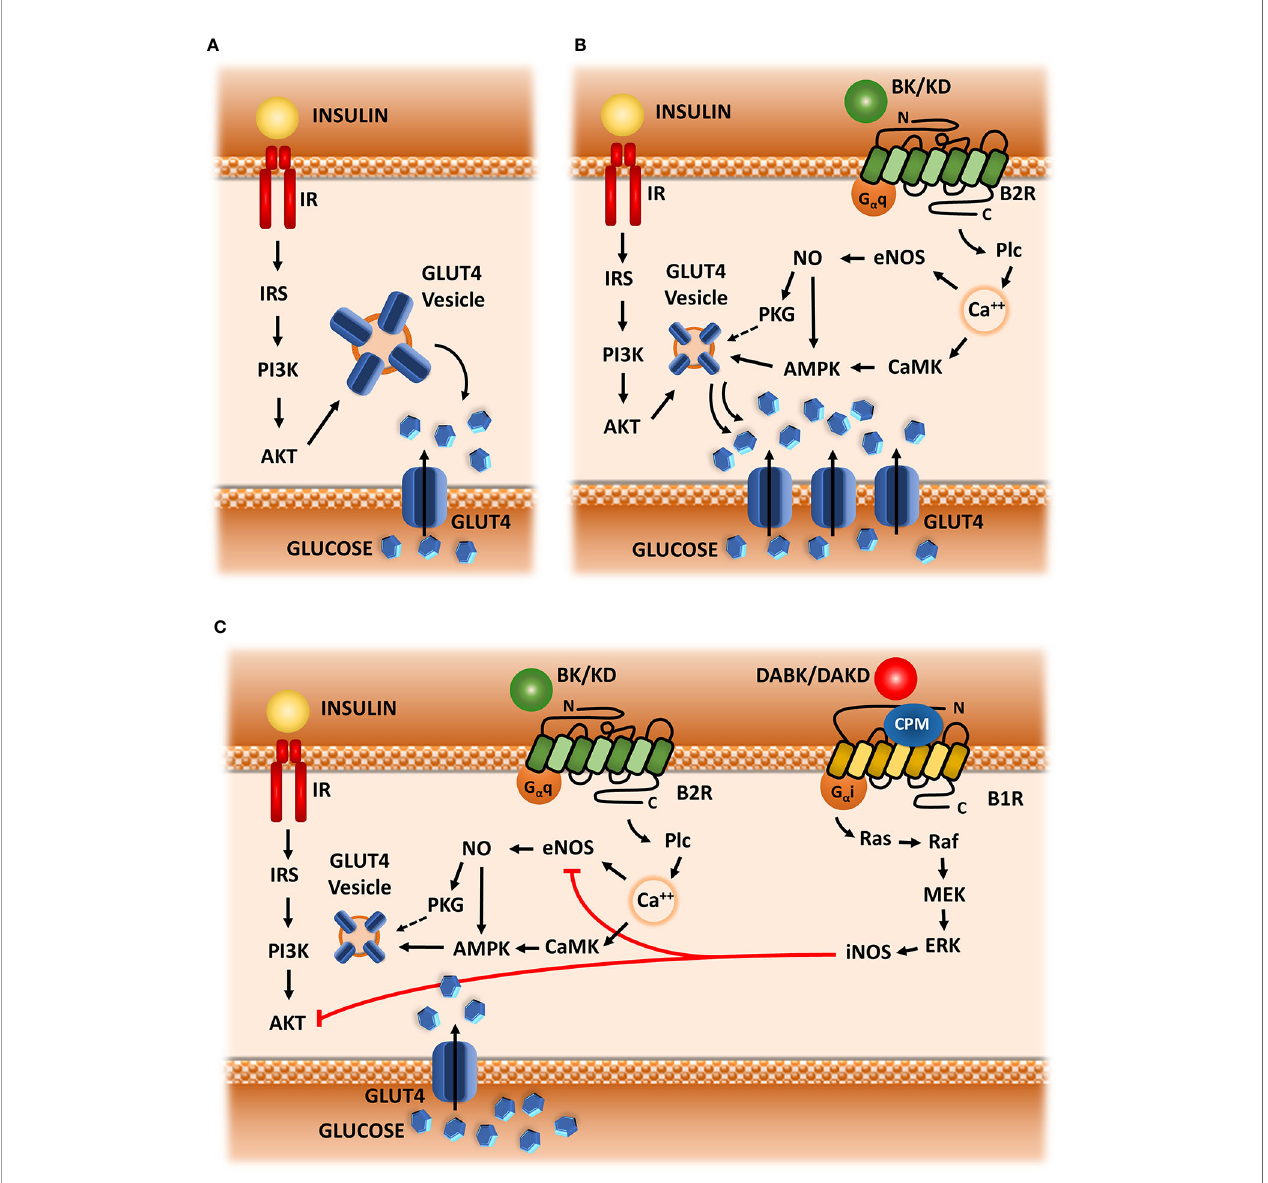
FIGURE 2 | Hypothetic scheme. (A) Insulin signaling. Insulin-mediated glucose uptake in adipose tissue and skeletal muscle, which is triggered by IRS-1 phosphorylation, followed by activation of PI3k and AKT, leading to GLUT-4 translocation to membrane. (B) Kinin signaling via B2R. Signaling starts with Plc activation, followed by calcium release from intracellular storage, CAMK activation, eNOS phosphorylation and NO synthesis, leading to AMPK and PKG activation, and subsequently to increased GLUT4 translocation. (C) Kallikrein-Kinin System in glucose uptake. B1R is up-regulated in metabolic disturbances, as well as CPM enzyme, converting B2R agonists (BK or KD) into B1R agonists (DABK or DAKD). B1R pathway starts with the activation of G-alpha-i and beta-gamma subunit, leading to the activation of the following kinases: Src, Ras, Raf, MEK, and ERK.ERK activate iNOS leading to exacerbated NO production. Increased NO impairs glucose uptake, blocking eNOS and AKT